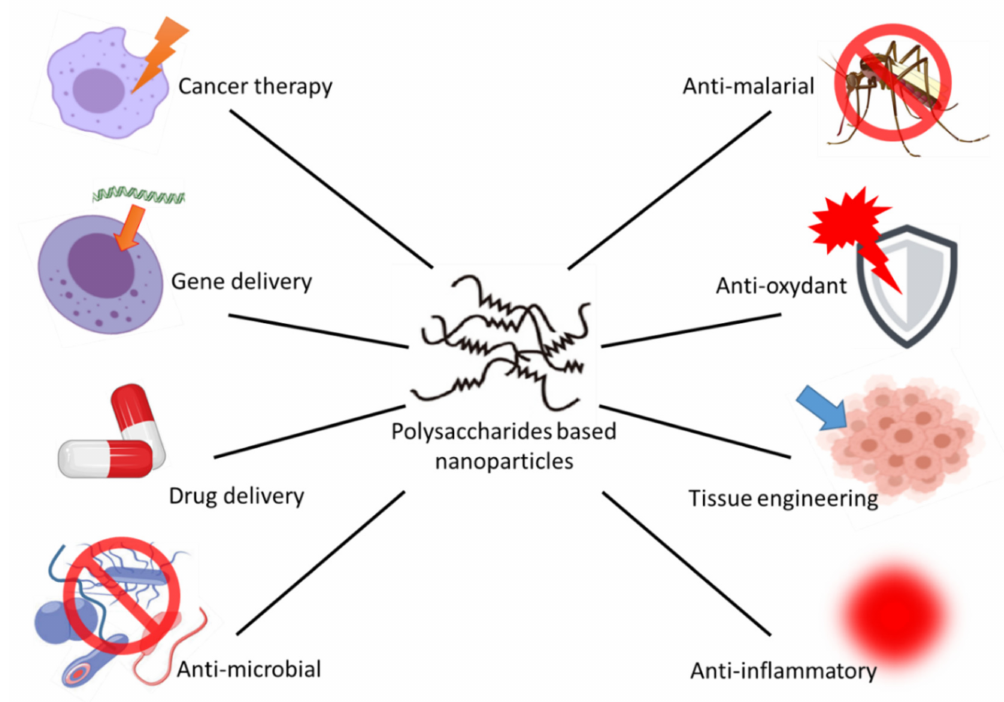
Figure 1. Schematic representation of the nano-biotechnological applications of polysaccharide-based nanoparticles